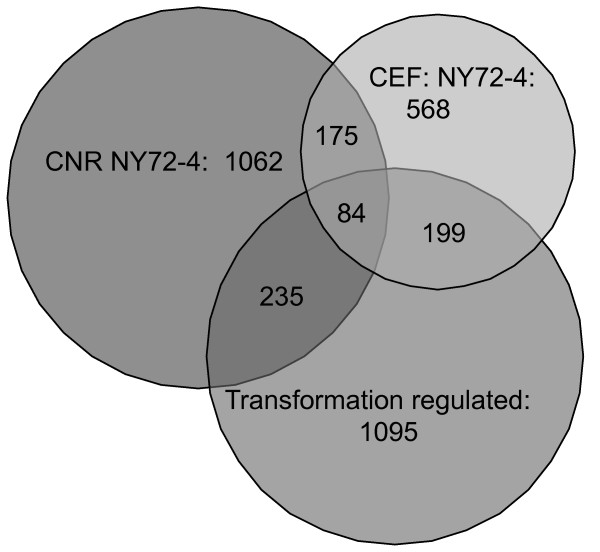
Euler representation of genes differentially expressed between control and v-Src transformed cells. Comparison of gene sets differentially expressed by two-fold between CEF or CNR cells infected with the temperature sensitive mutant NY72-4 RSV, or the set of Transformation-Regulated (TR) genes defined in Additional File 3. Numbers indicate total probe sets.